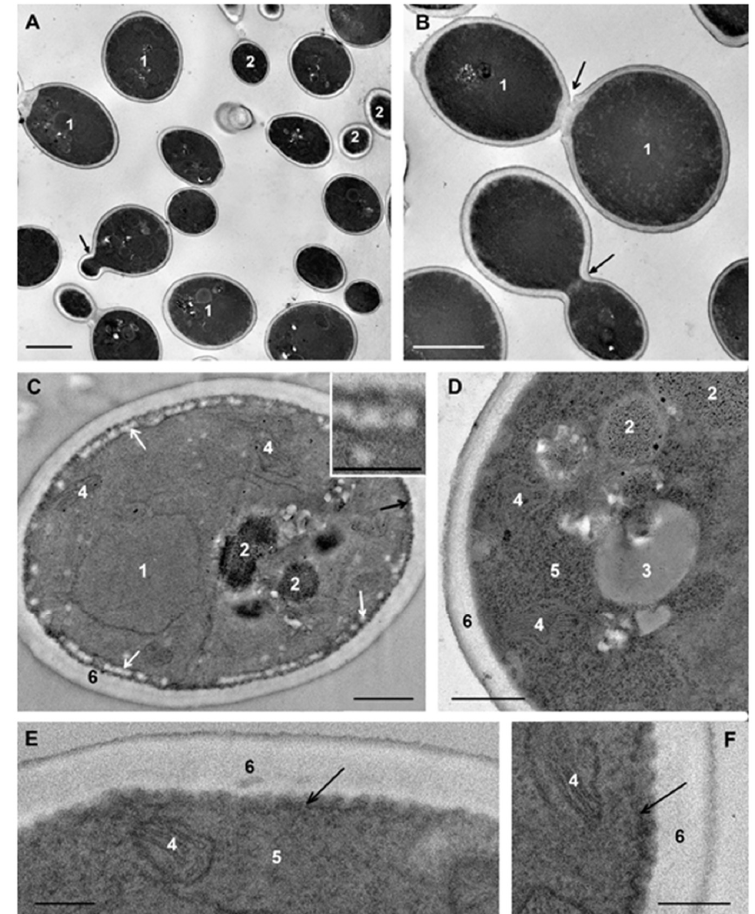
Figure 2. Ultrastructure of C. albicans intact cells. ( A , B ) general view of the suspension: 1–sections through the cell central part; 2–cell fragments; black arrows show budding cells. ( C ) “a tape” of “balls” at the cell periphery (shown by white arrows); the insert shows “balls” at high magnification. ( D ) cell organoids; ( E , F ) areas of the cells with a wavy plasma membrane (shown by black arrows). 1 –nucleus; 2 –vacuole; 3 –lipid droplet; 4 –mitochondria; 5 –cytoplasm; 6 –cell wall. ( E , F ) ultrathin sections without contrast. Scale bars correspond to: 2 μm ( A , B ), 500 nm ( C , D ), and 200 nm ( E , F ).